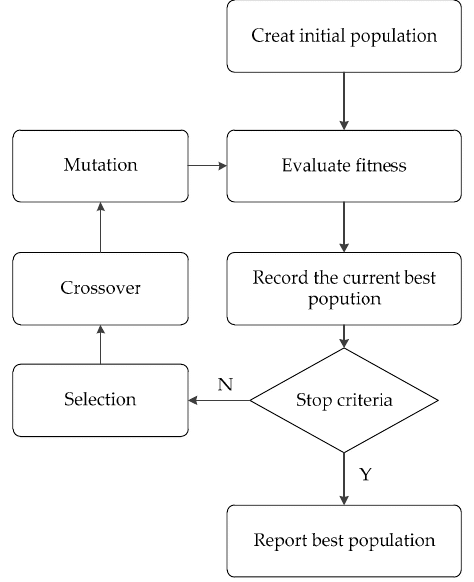
Figure 9. The process flow of a genetic algorithm.